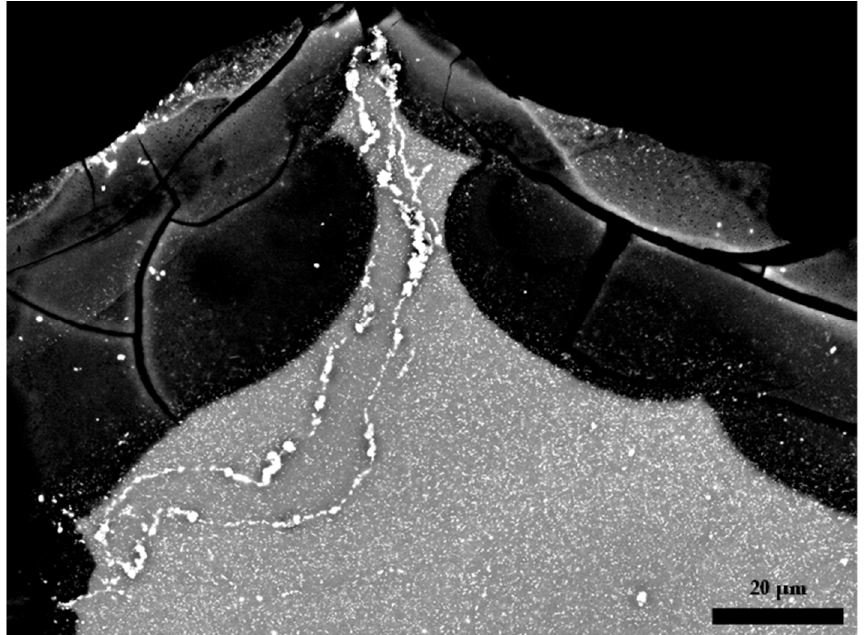
Figure 4. SEM BSE image of a sample corroded for 21 days, where microgalvanic corrosion is visible with the preferential dissolution of the α‐ Mg matrix, the white phases are Y and Nd rich intermetallic phases.